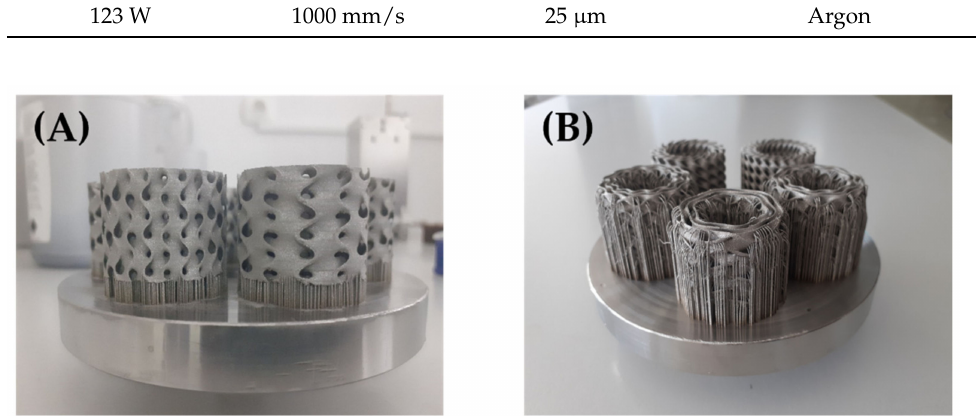
Figure 5. Comparison of support strategies: ( A ) for samples with n radial = 1 and n radial = 2; ( B ) for samples with n radial = 1.5.